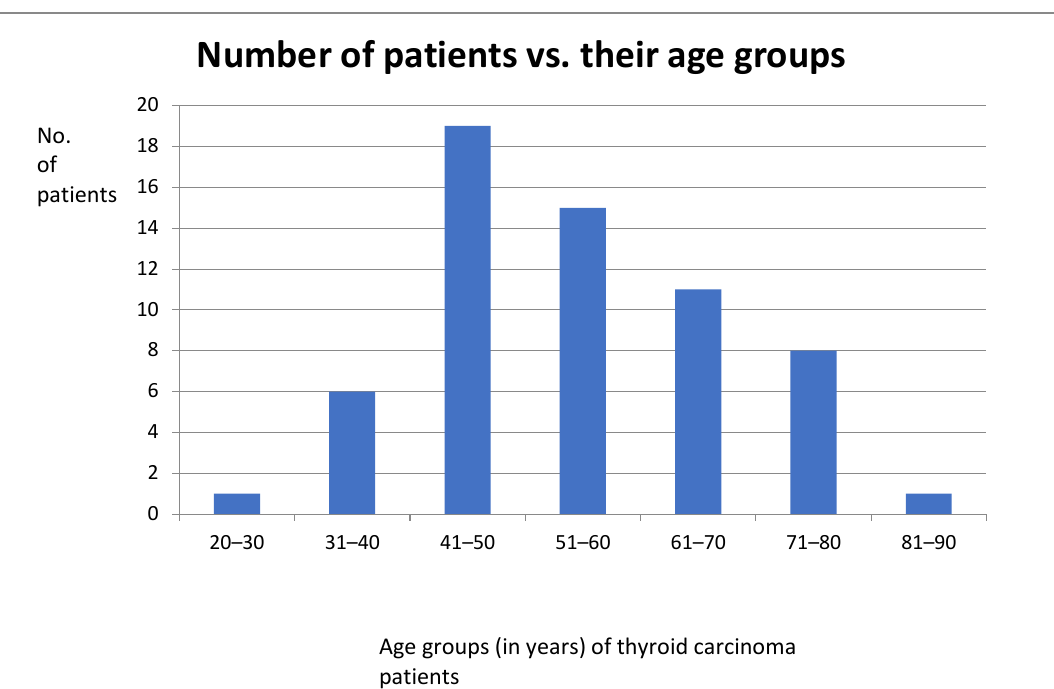
Figure 5. Bar graph showing distribution of patients and their age groups.